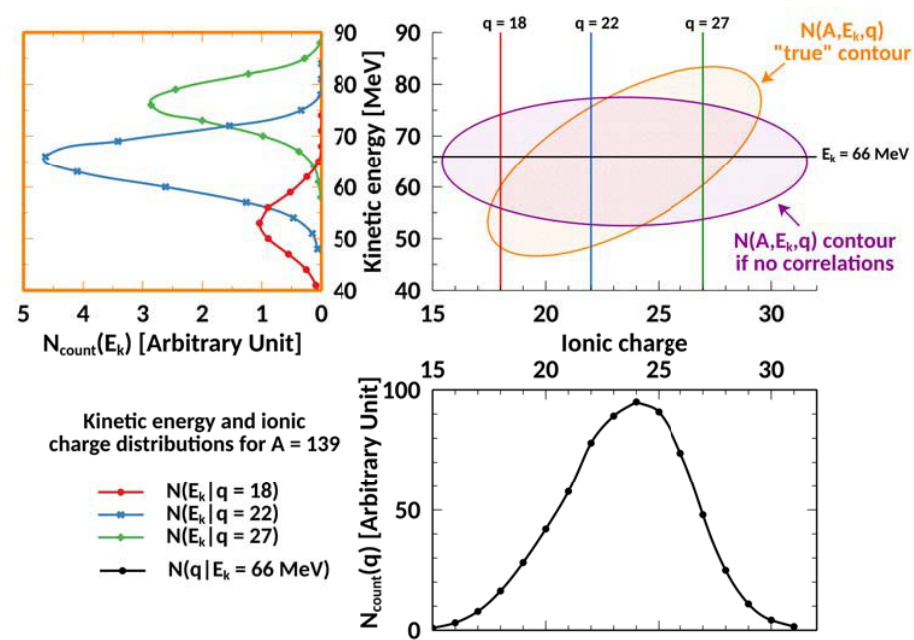
Figure 2. Dependence of the kinetic energy distribution as function of the ionic charge. The N ( A , q , E k ) contour is then rotated thanks to the correlation between ( E k , q ). Data are coming from the study on the 241 Pu( n th , f )